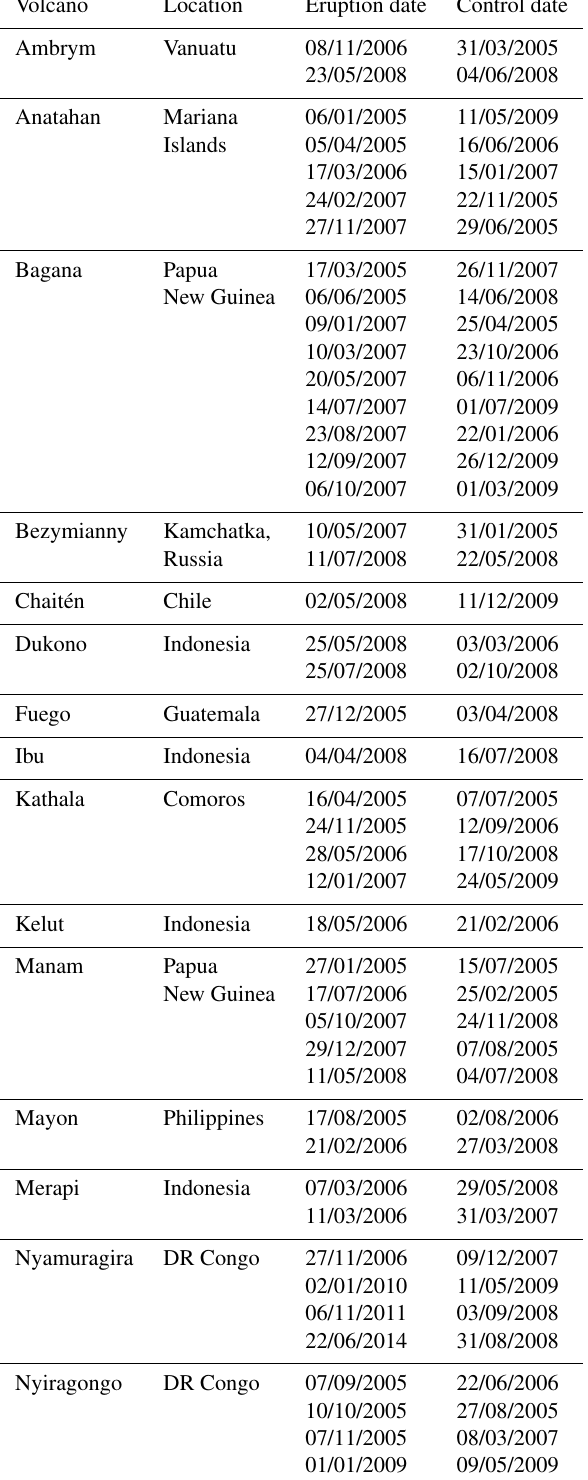
Table 2. Test dataset of volcanic eruption dates and control dates (organised alphabetically by